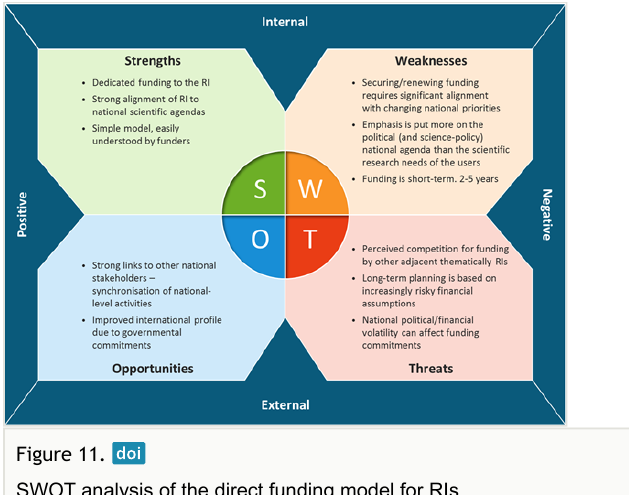
SWOT analysis of the direct funding model for